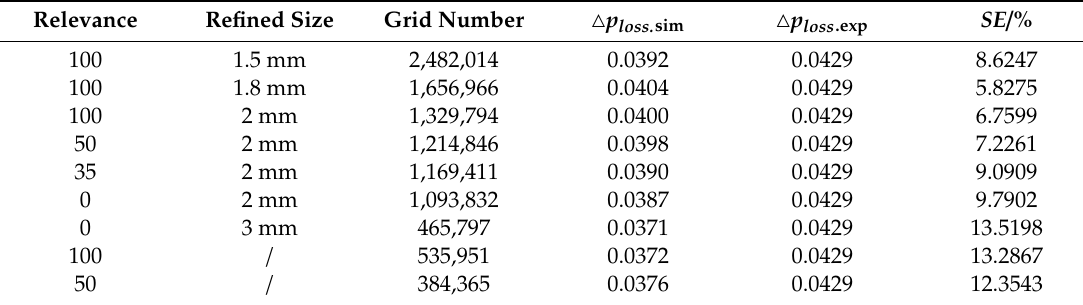
Table 4. Mesh sensitivity analysis for configuration